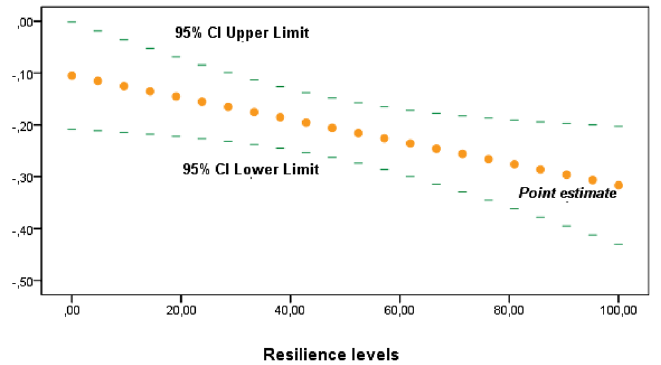
Figure 2. Johnson–Neyman method to study conditional effect of resilience as a moderator of the association between “Mood and Emotions” and Physical victimization. Y-axis represents β-coefficients.